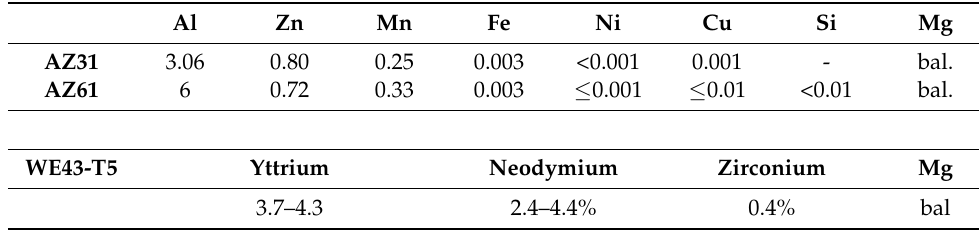
Table 1. Chemical composition of alloys AZ31, AZ61, and WE43-T5 (in %mass).